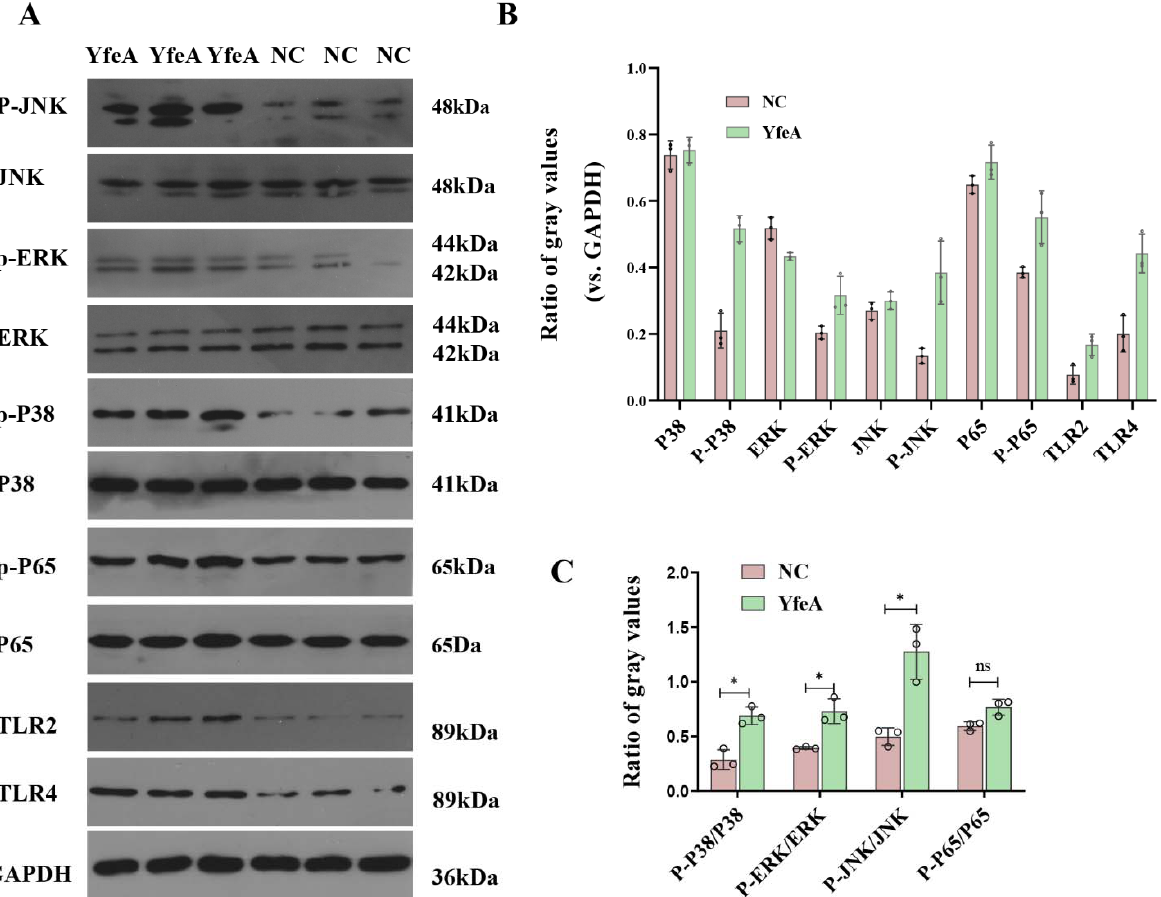
Figure 8. Detection of the signaling molecule involved in pro ‐ inflammatory cytokine secretion. RAW 264.7 were plated into 6 ‐ well plates at a density of 2 × 10 6 cells/well overnight, then pre ‐ incubated with 20 μ g/mL YfeA protein or DMEM for 12 h. The total protein was used to detect signaling molecules in MAPK and NK ‐κ B signaling pathways. ( A ) Western blot analysis. ( B ) Gray intensity. ( C ) Ratios between phosphorylated activated signal molecules and signal molecules. Significant differences between groups are indicated by * p < 0.05, ns p < 0.05.